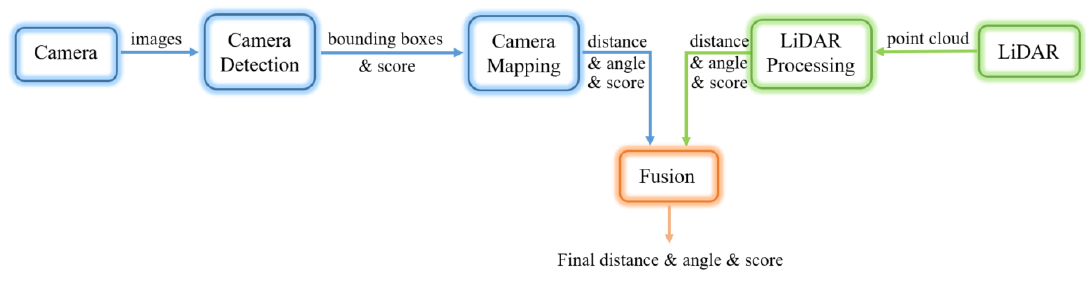
Figure 3. Proposed fusion system high-level block